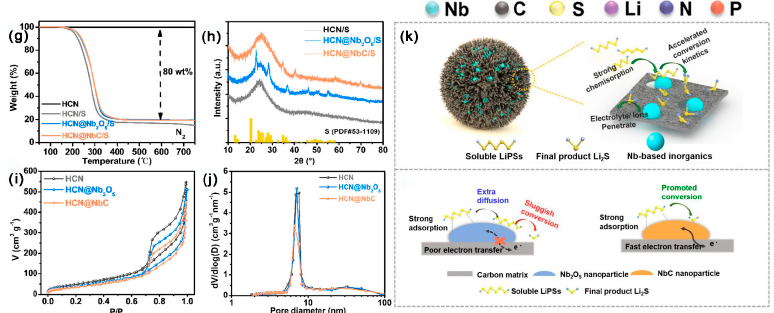
Figure 17. ( a ) Schematic diagram of the preparation of TSC/NbC. ( b – d ) SEM images of TSC/NbC, den- sity functional theory calculations of the adsorption energy for Li 2 S 6 . Optimized atomic structures of ( e ) NbC-Li 2 S 6 , ( f ) pure C-Li 2 S 6 , quaternary-N/C-Li 2 S 6 , pyridinic-N/C-Li 2 S 6 and P/C-Li 2 S 6 [113]. ( g ) TGA curves under N 2 atmosphere, ( h ) XRD pa tt erns, ( i ) N 2 adsorption/desorption isotherms (The upper curve represents the desorption isotherm, while the lower curve represents the adsorption iso- therm), and ( j ) pore size distributions of HCN@NbC. ( k ) Mechanism of the action of Nb 2 O 5 /C and NbC/C on LiPSs [115]. 3.2.8. Metal Phosphates Composite MCBM Metal phosphides are polar materials with the highest electrical conductivity relative to its oxides and sul fi des. In addition, the synthesis conditions for metal phosphides are simpler and milder than nitrides and carbides. Metal phosphates composite MCBM have gained a lot of a tt ention in recent years. As shown in Figure 18a–d, by phosphating and pyrolyzing acrylic resin, Shen et al. [116] created a mesoporous 3DC framework that was implanted with CoP nanoparticles (CoP@3DC). The SSA of CoP@3DC was 867.78 m 2 g − 1 , the pore diameter distribution was 5–15 nm. The mesoporous construction of CoP@3DSC inhibited the shu tt le e ff ect, and the high conductivity of 3DC was conducive to the electron transport. The uniformly distrib- uted CoP nanoparticles in 3DC improved the chemisorption and conversion of LiPSs to Li 2 S. Consequently, at 0.5 C, the initial DSC of LSBs with CoP@3DC/S cathode was 1117.37 mAh g − 1 ; notably, the DSC was still kept at 740.56 mAh g − 1 after 600 cycles, with a CDR of 0.056% per cycle. At 1 C, the initial DSC was 936.80 mAh g − 1 , and the DSC was still kept at 640.00 mAh g − 1 after 500 cycles, with a CDR of 0.0528% per cycle. As shown in Figure 18e– i, Hu et al. [117] embedded FeP nanoparticles into hierarchical porous C microspheres (PCM/FeP). The SSA of PCM/FeP was 500 m 2 g − 1 , the mesoporous diameter was 4 nm, and the TPV was 0.9 cm 3 g − 1 . Under the restriction of mesopores, PCM might strengthen the interaction between FeP and S species and increase the catalytic sites exposure of FeP na- noparticles. FeP could improve the chemisorption of LiPSs and optimize the transfor- mation kinetics of LiPSs to Li 2 S. Consequently, at 0.5 C, the initial DSC of LSBs with a PCM/FeP/S cathode was 1231 mAh g − 1 ; notably, the DSC was still kept at 910.7 mAh g − 1 after 500 cycles, with a CDR of 0.05% per cycle.